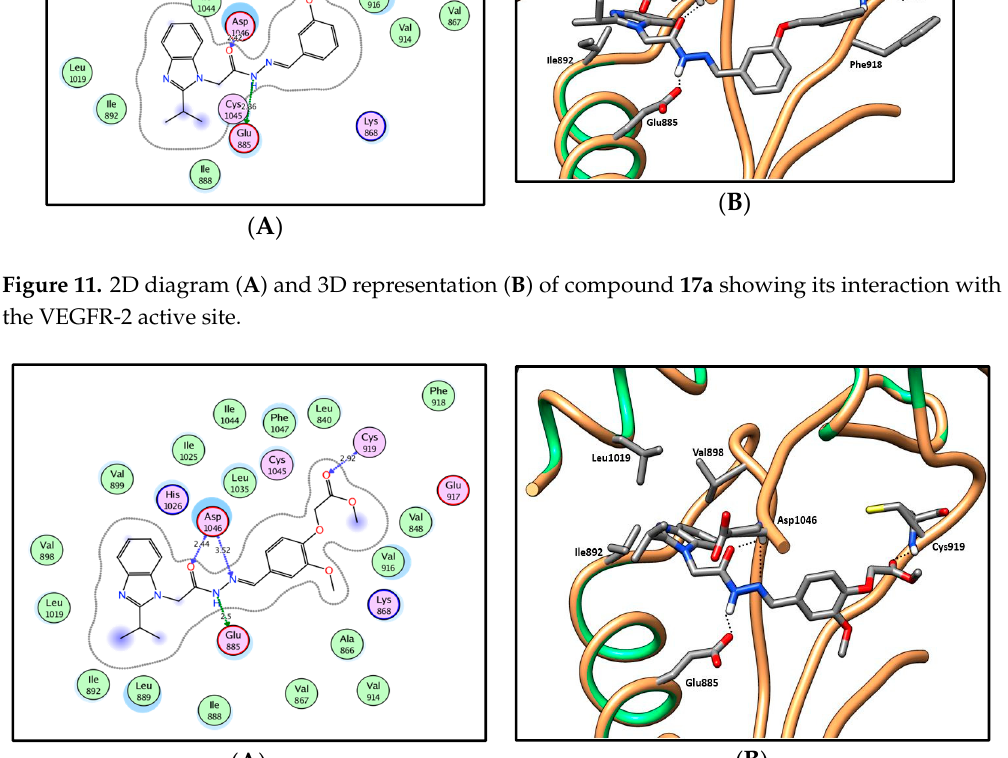
Figure 11. 2D diagram ( A ) and 3D representation ( B ) of compound 17a showing its interaction with the VEGFR-2 active site .